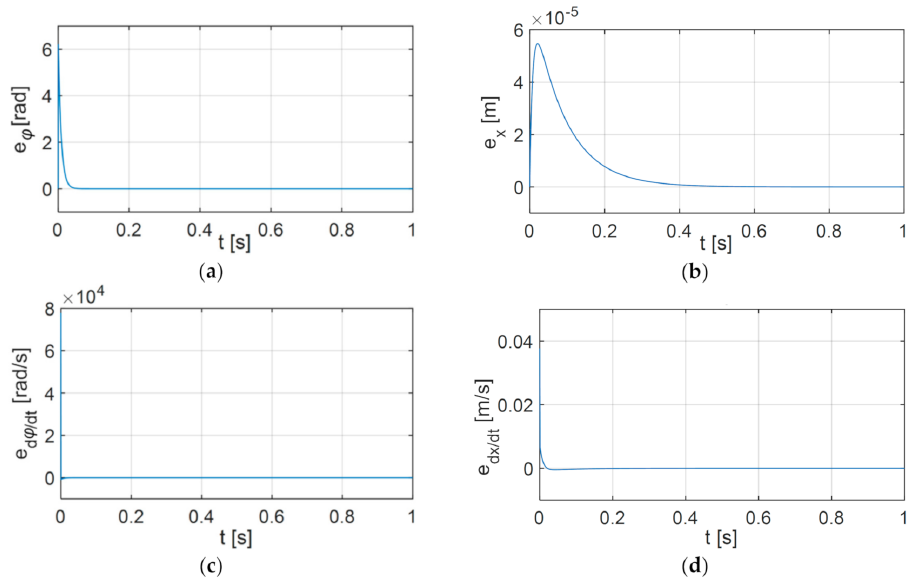
Figure 15. Follow-up movement errors: ( a ) position error of the active part e ϕ ; ( b ) position error of the passive part e x ; ( c ) speed error of the active part e d ϕ / dt ; ( d ) speed error of the passive part e dx / dt